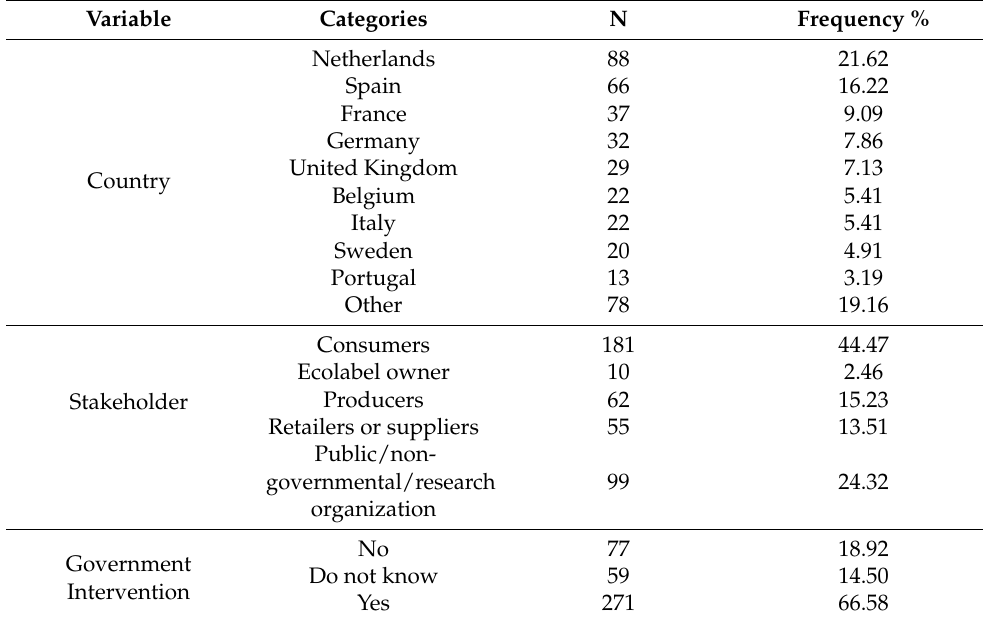
Table 2. Socio-demographic characteristics of the